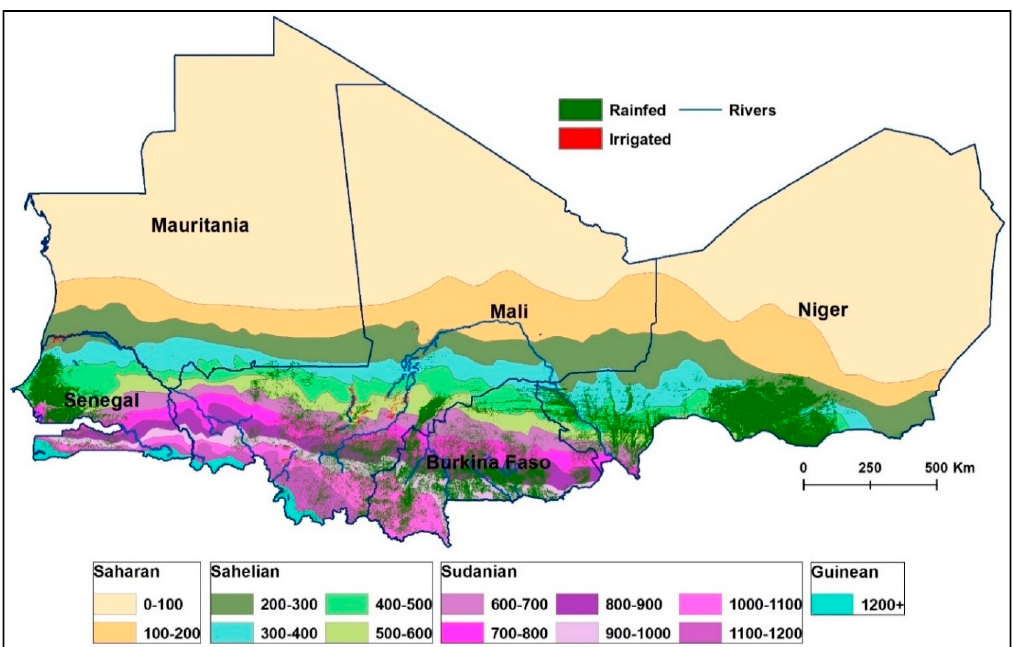
Figure 10. Cropland extent across gradient of mean annual precipitation. Precipitation is an average of 11 years (2005–2015). CHIRPS (Climate Hazards Group InfraRed Precipitation with Station) data. The second largest zone is the Sahelian (200–600 mm), occupying 23% of the total study area. Rainfed cropland intensity increases with annual rainfall (Figure 11). Compared to the other climatic zones, the Sahel has the highest proportion of irrigated cropland, as irrigation activities along both Niger and Senegal rivers occur mainly in this climatic zone (Figure 10). This irrigation proportion is, however, less than 1% against about 15% for rainfed agriculture (Table 5).